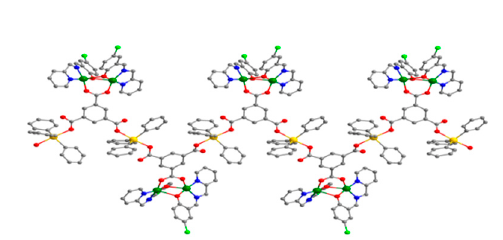
Figure 1. Structure of compound 3